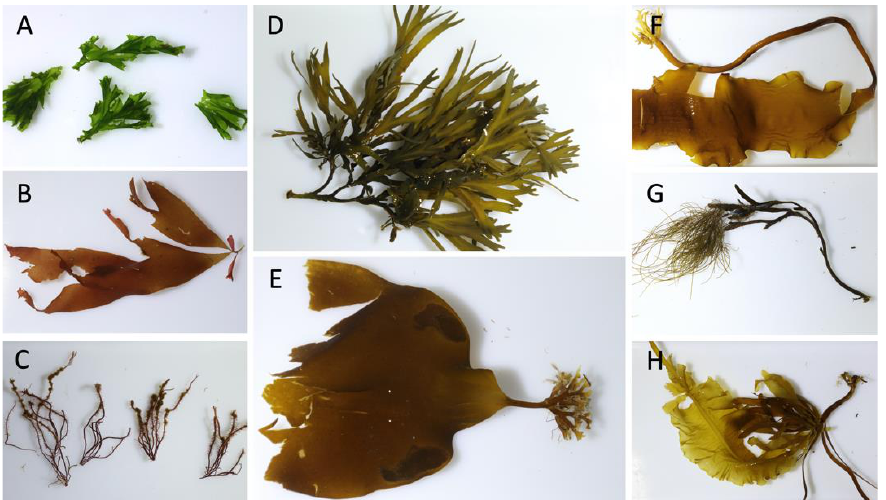
Figure 4. The 8 major macroalgal species sampled from Kongsfjorden macroalgal habitat in